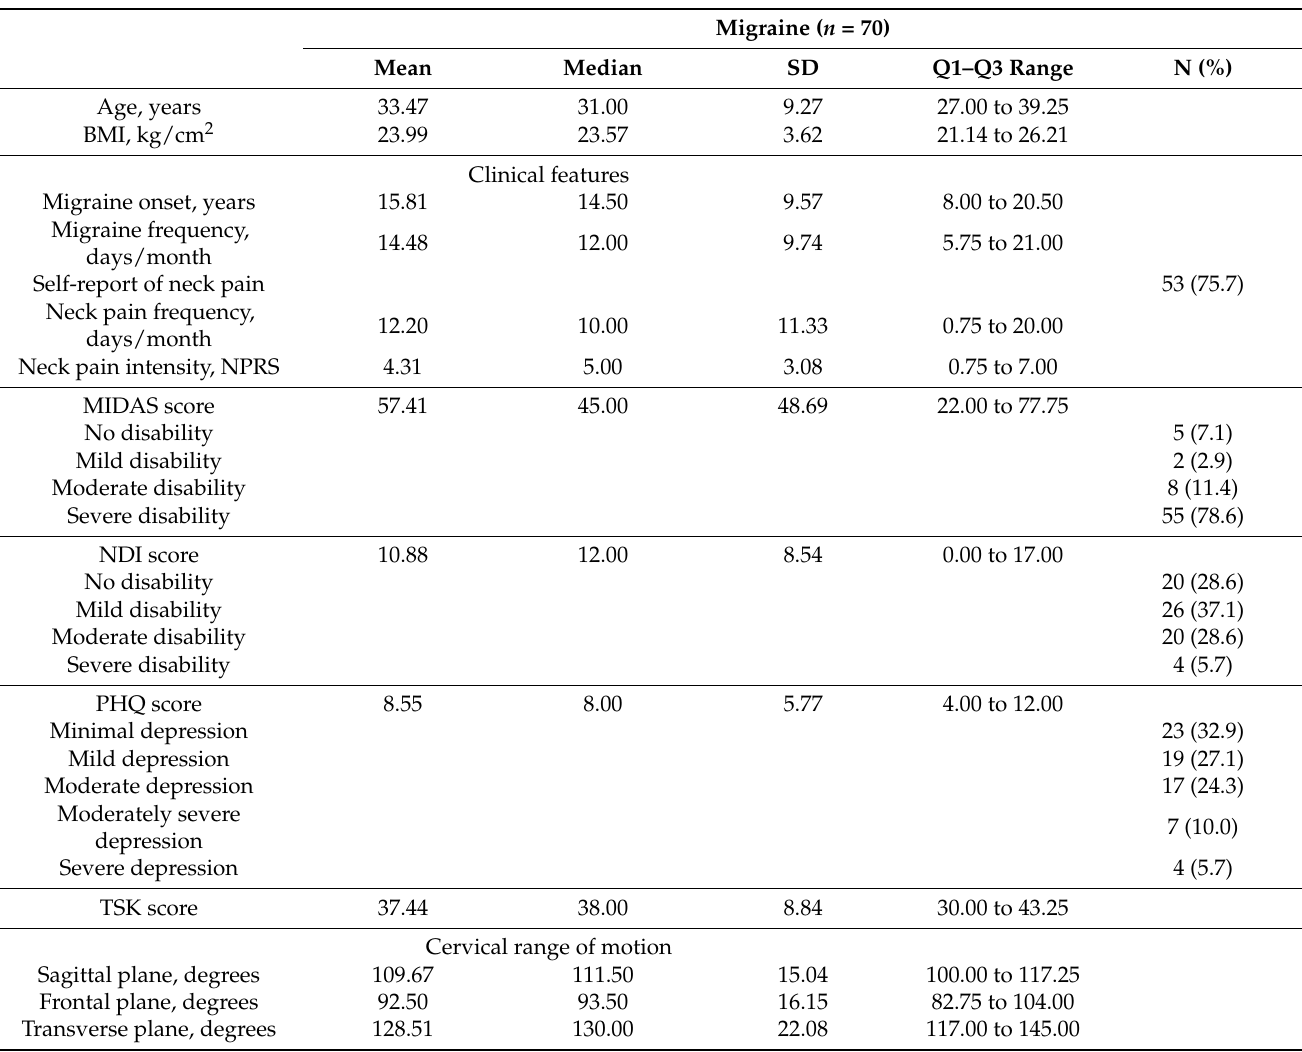
Table 1. Sample clinical and demographic characteristics.